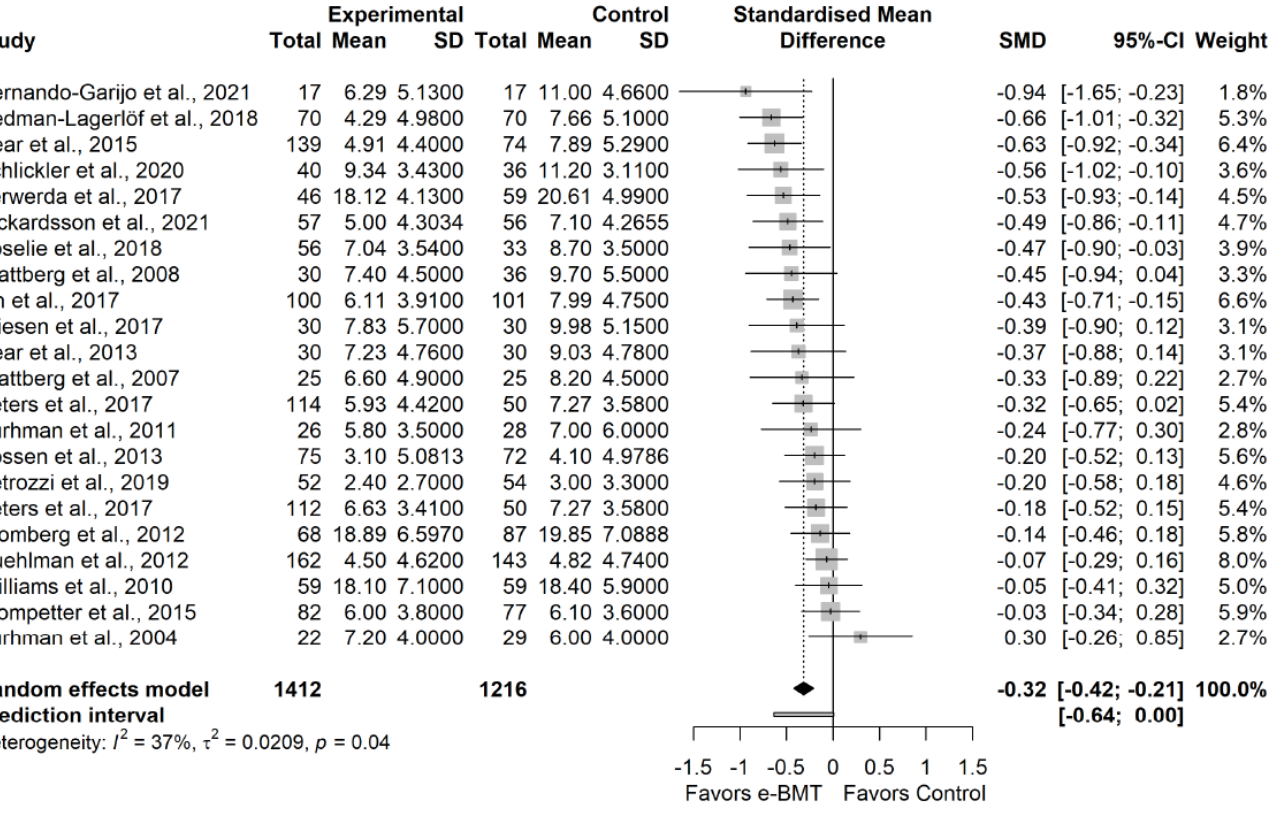
Figure 3. Sensitivity analysis of the anxiety variable for telematic behavioral modification tech- niques against usual care or waiting list. Negative results favor the intervention group. The small boxes with the squares represent the point estimate of the effect size and sample size. The lines on either side of the box represent a 95% confidence interval (CI). e-BMT: Telematic Behavioral Modification Techniques.